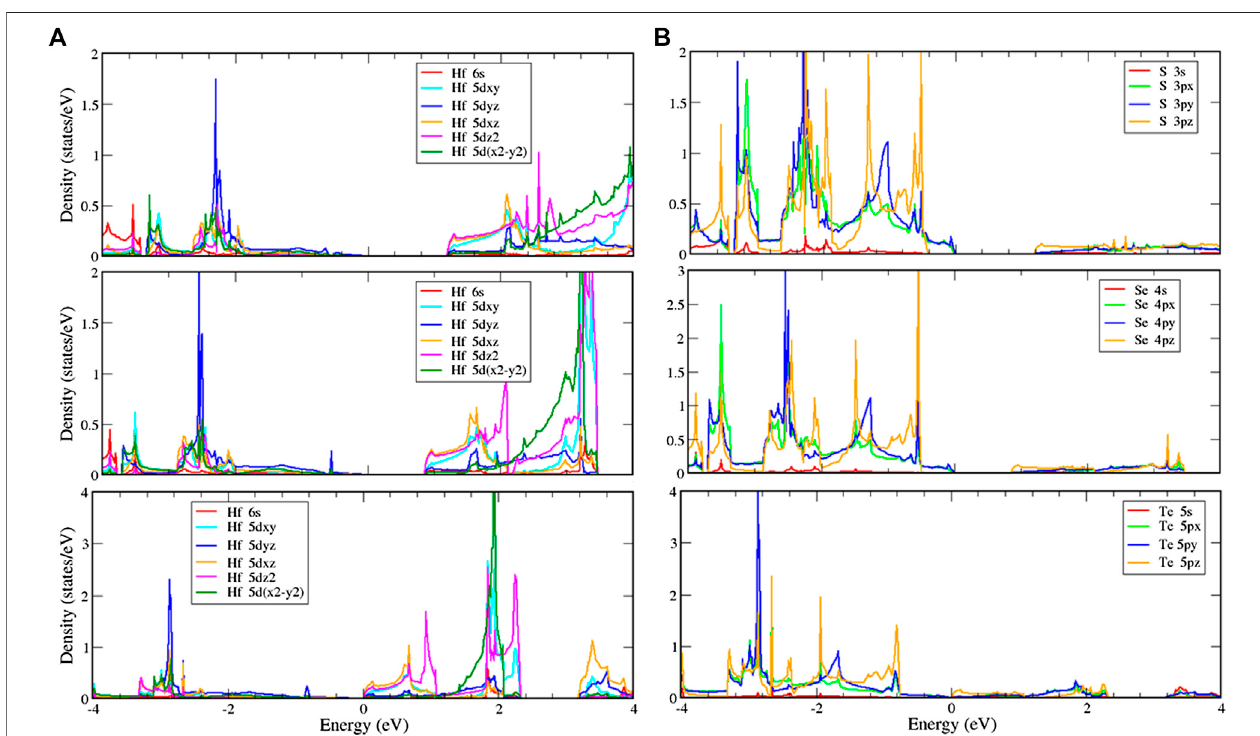
FIGURE 6 | Local density of states (LDOS) of (A) hafnium and (B) chalcogen atoms with multi-orbital hybridization in the T phase.